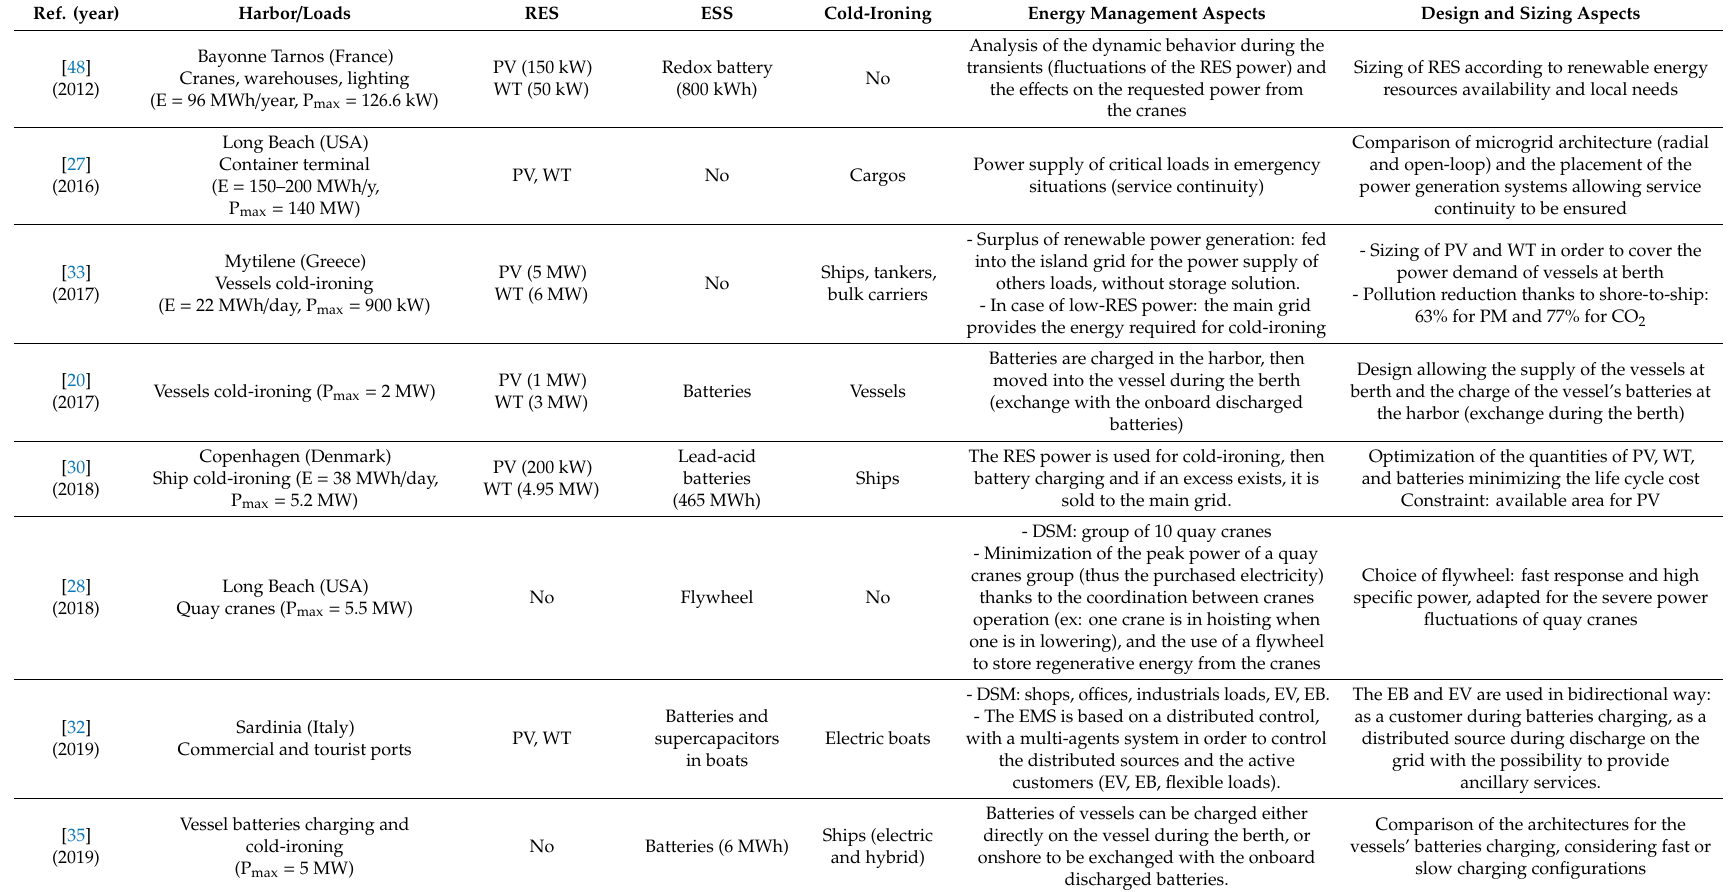
Table 1. Summary of the publications dealing with the energy management and the sizing of microgrids in harbor